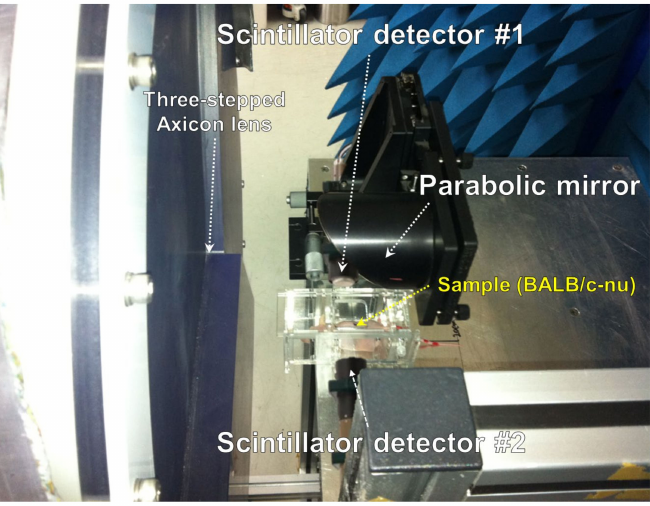
Figure 9. Setup of PALS system in vivo (the positron lifetime of a single event can be measured by detecting the time difference between the birth γ -quantum of the β + -decay in the 22 Na source and one of the annihilation γ -quanta of an energy of 511